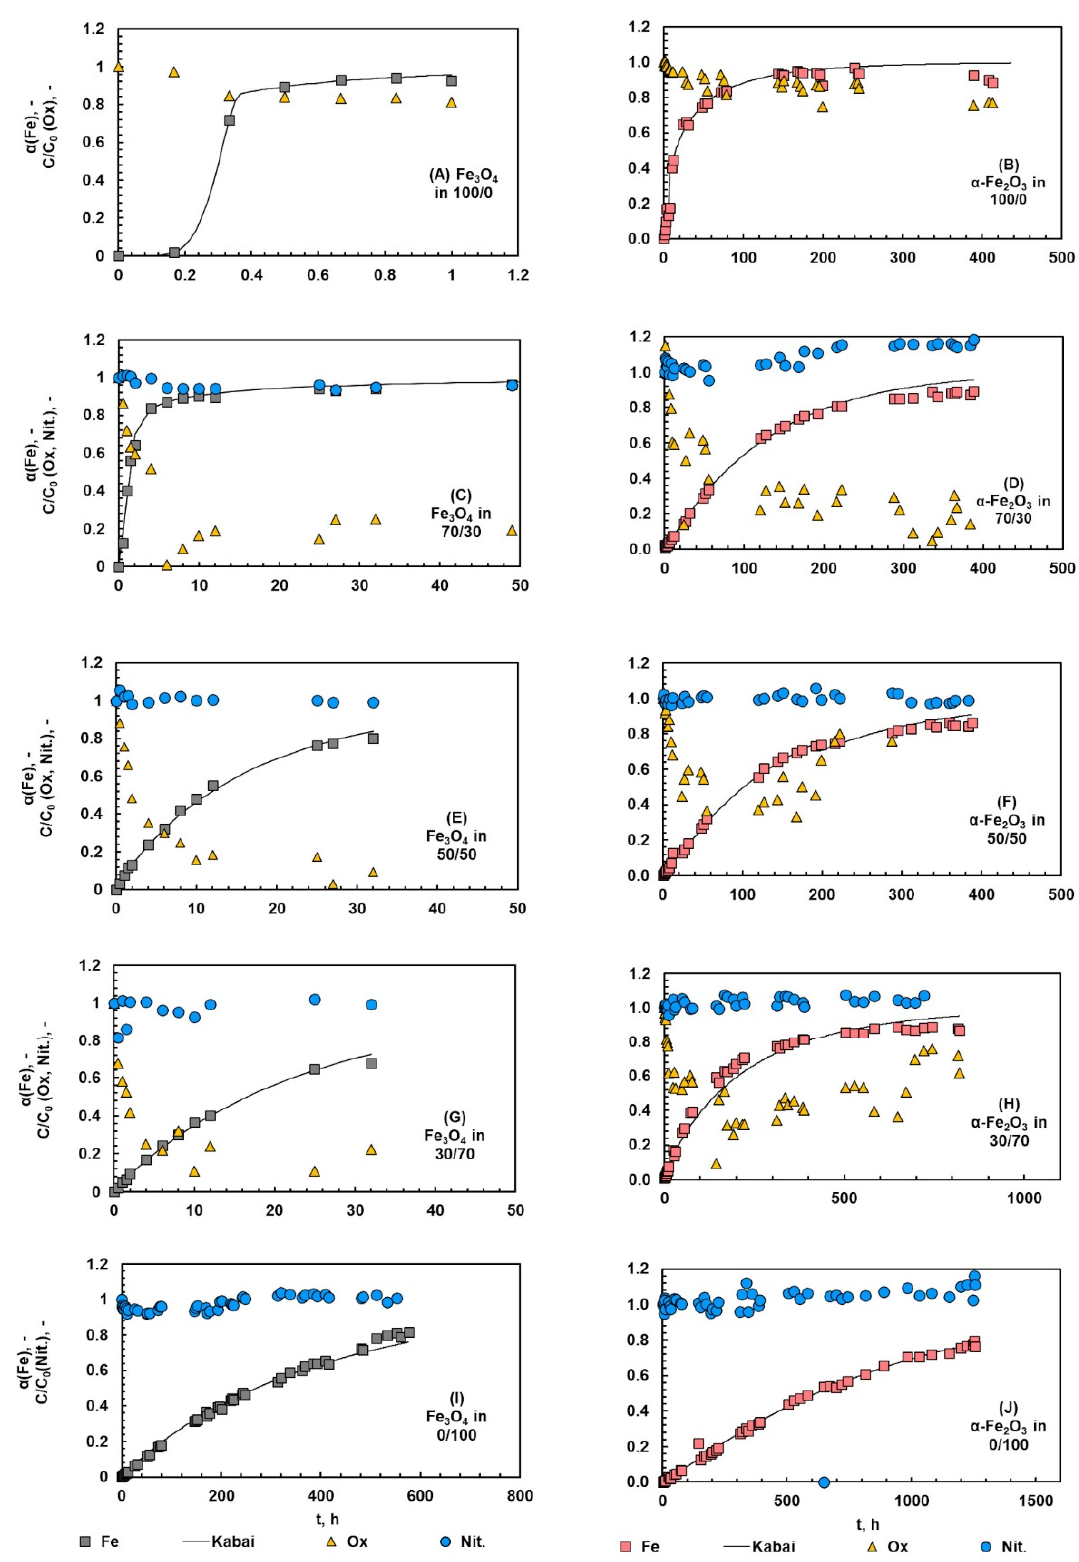
Figure 6. Fraction of dissolved iron and the normalized oxalate and nitrate ion concentrations during the dissolution of magnetite ( A , C , E , G , I ) and hematite ( B , D , F , H , J ) in different Ox/HNO 3 systems. The temperature was 35 °C.